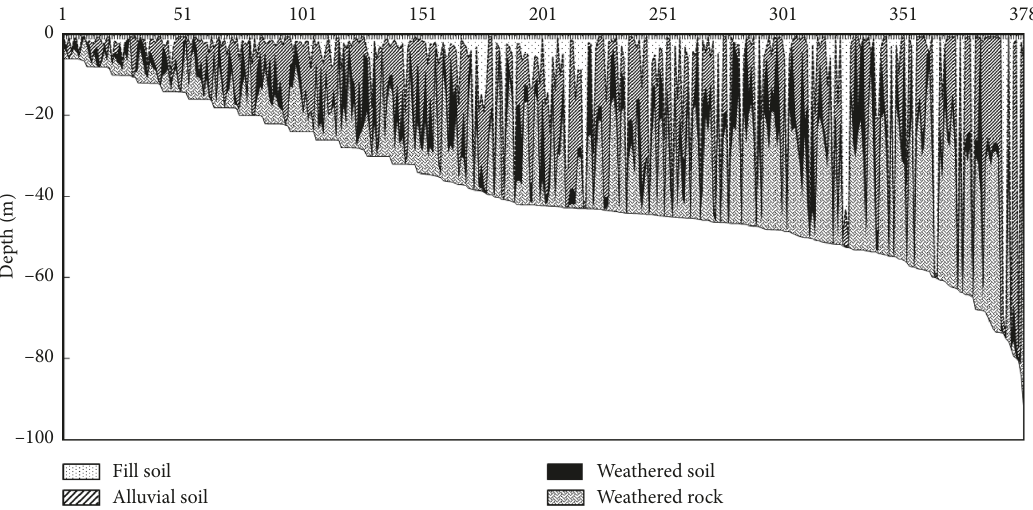
Figure 1: 378 soil strata from